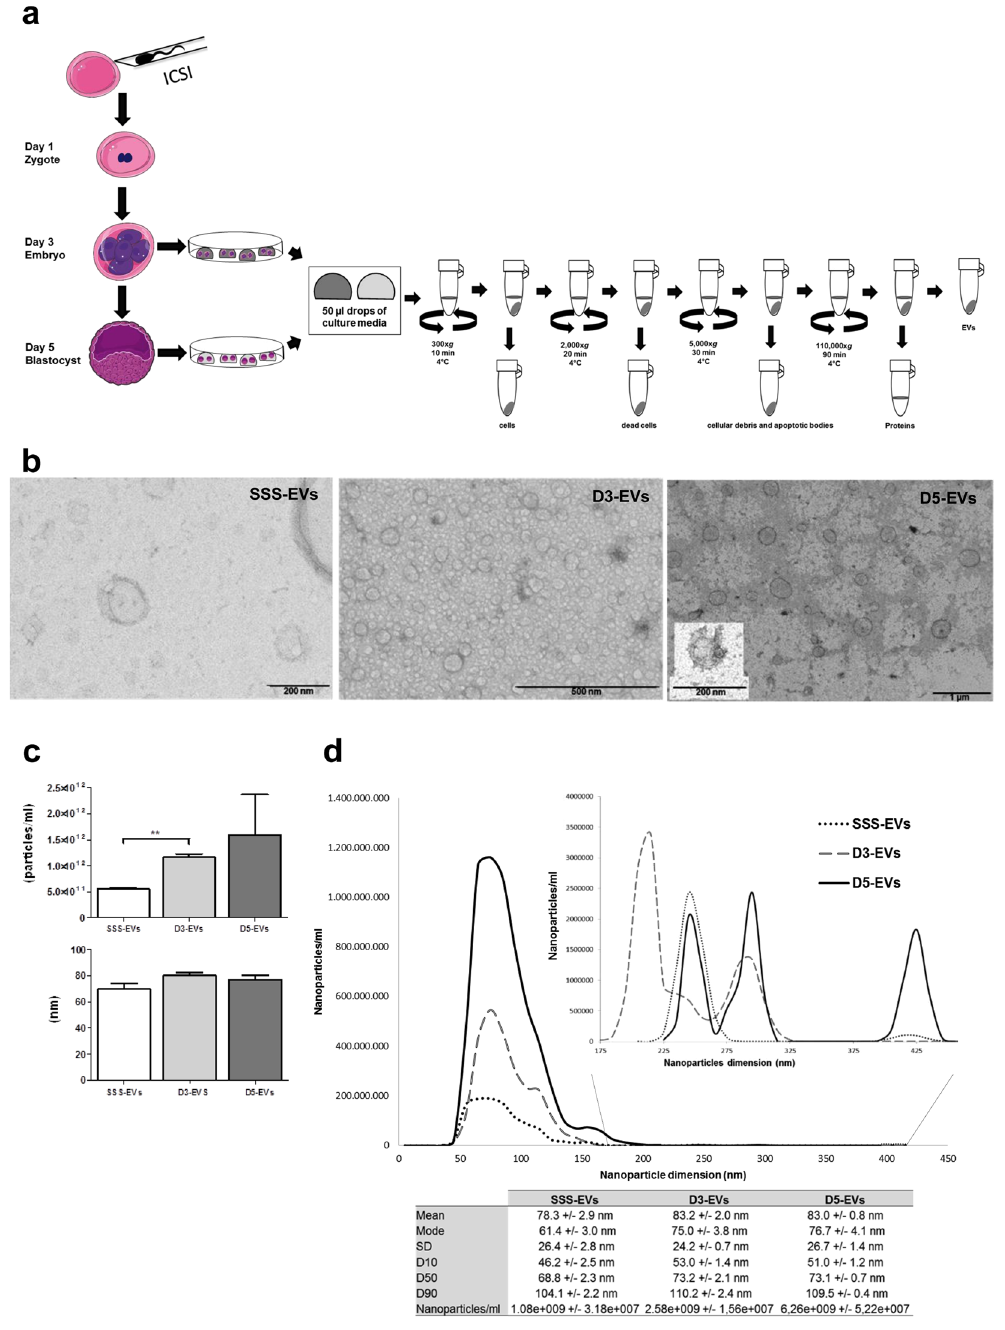
Figure 1. Day 3 and day 5 embryos release a heterogeneous population of EVs. ( a ) Schematic overview of the isolation protocol used to obtain EVs from embryo spent media accumulated from day 1 to day 3 (D3-EVs) or from day 3 to day 5 (D5-EVs) of development. ( b ) Fresh D3-EVs or D5-EVs isolated from six embryos were negatively stained with uranyl acetate and visualized by TEM. EVs isolated from SSS-supplemented medium (SSS-EVs) are also shown (left panel). Data shown are representative of 3 independent experiments. ( c ) Concentration defined as particle/ml (upper panel) and size distribution (lower panel) profiles were determined by NTA using 50 µ l of spent media from six day 3 or day 5 embryos. Size and number of SSS-EVs are also shown. Results are expressed as mean ± SEM, n = 4 ( ** p = 0.001, D3-EVs vs SSS-EVs). ( d ) A representative tracking analysis plot of SSS-EVs (dilution 1:500) and of D3-EVs and D5-EVs (dilution 1:500). To better visualize peaks, a different scale was used for nanoparticles of diameter higher than 175 nm. The mode, mean value, standard deviation of size and concentration for each sample are provided. The value D50 represents the median size. Similarly, 90 percent of the distribution lies below the D90 value, and 10 percent of the population lies below the D10